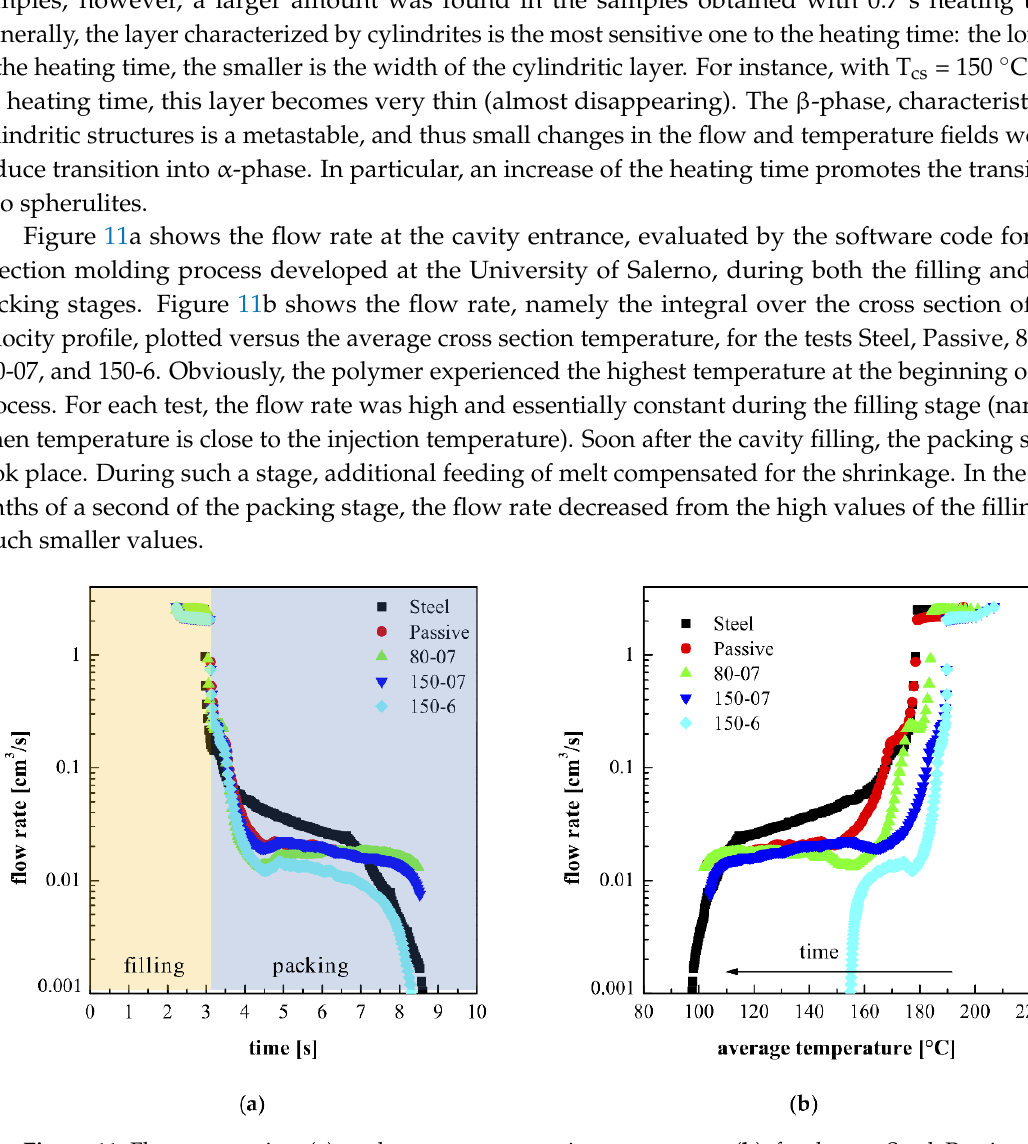
Figure 11. Flow rate vs time ( a ), and average cross section temperature ( b ), for the test Steel, Passive, 80-07, 150-07 and 150-6. 80-07, 150-07 and